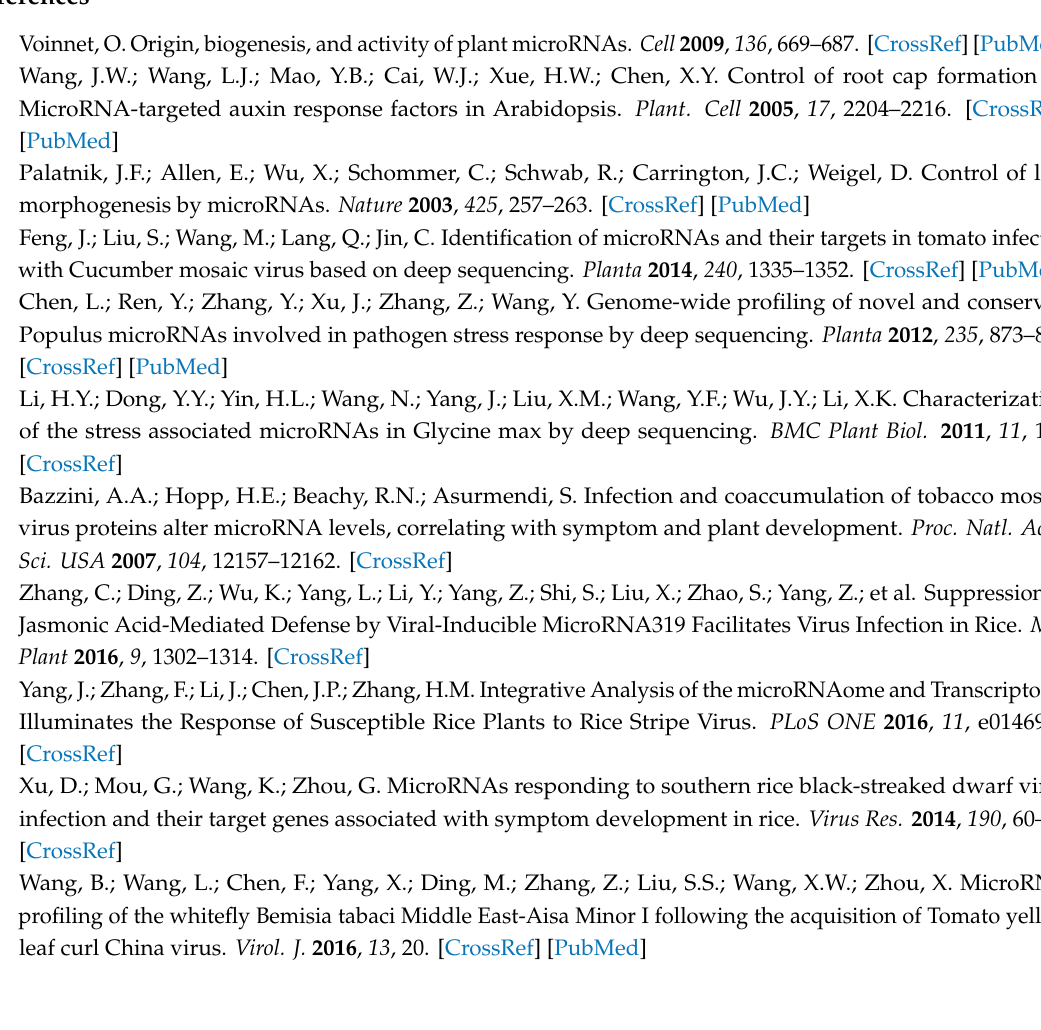
Table S1. PCR primers used for TbCSV and TbCSB detections and plasmids construction. Table S2. qRT-PCR primers used for miRNA and mRNAs detections. Figure S1. The expression level of nbe-miR1919c-5p in TbCSV and TbCSB co-infected N. benthamiana